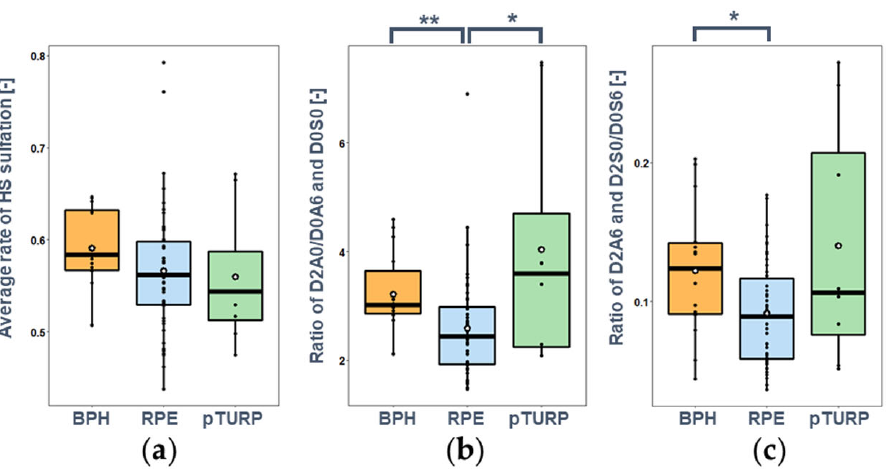
Figure A4. Sulfation characteristics of HS chains as a function of the type of surgery: ( a ) average rate of HS sulfation; ( b ) O/N ratio of the monosulfated disaccharides; ( c ) O/N ratio of the disulfated disaccharides. (*: p < 0.05, **: p < 0.01). See Figure 1 for resolving the GAG structure codes.